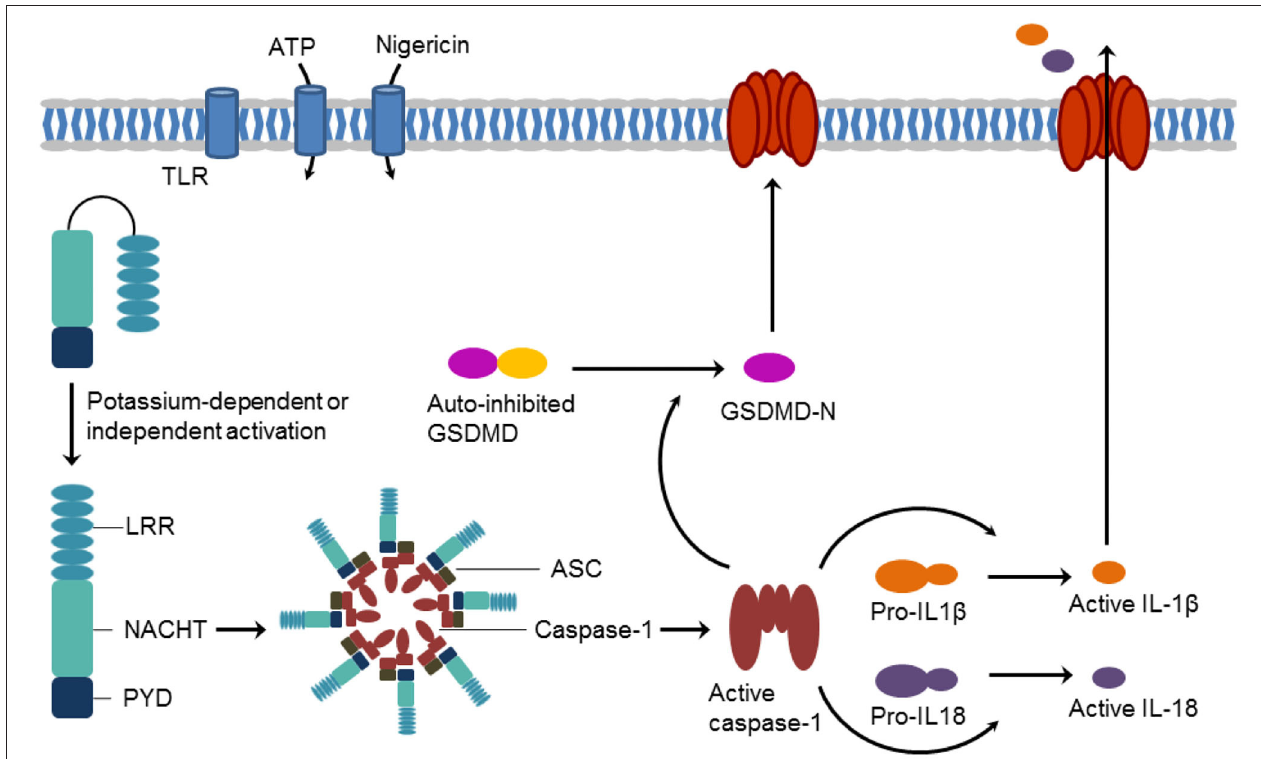
FIGURE 1 | Schematic formation of the NLRP3 inflammasome and induction of